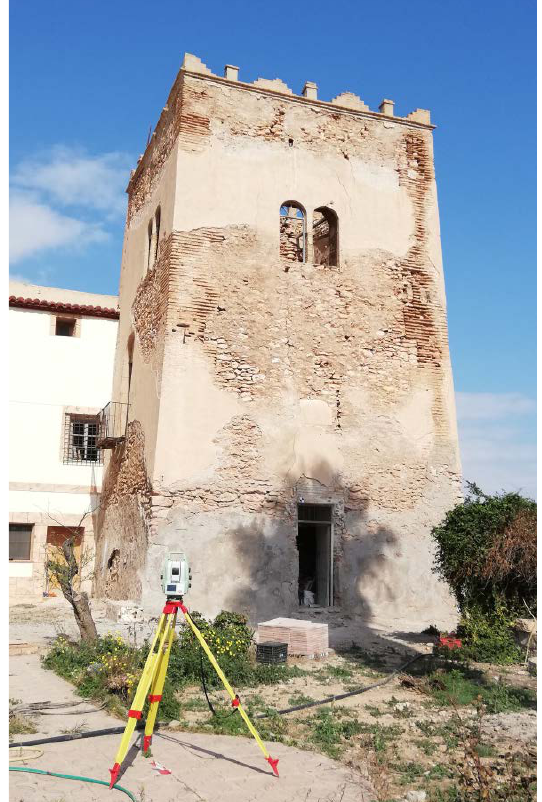
Figure 2. West façade attached to the rural house and South façade of the Negro Tower during the data collection phase.